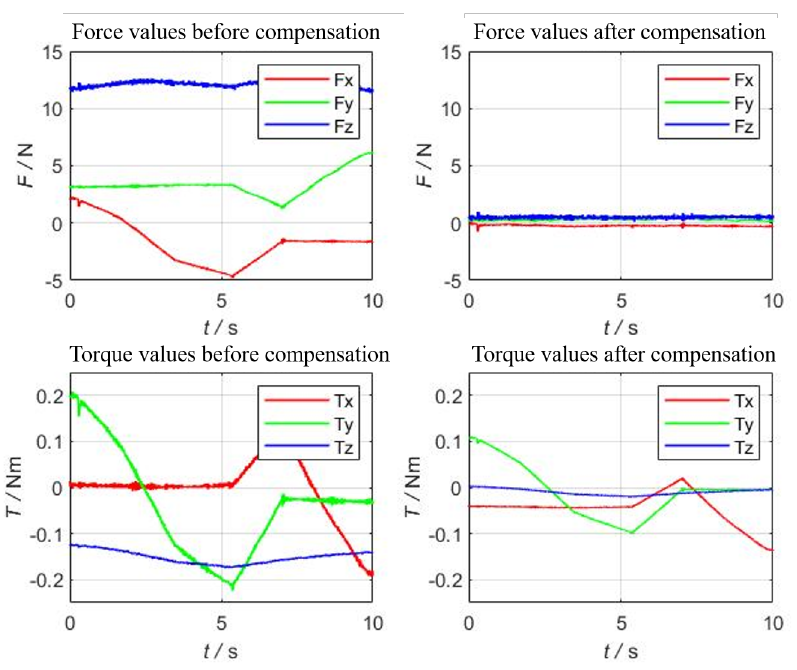
Figure 6. Results after compensation of gravitational and inertial forces.